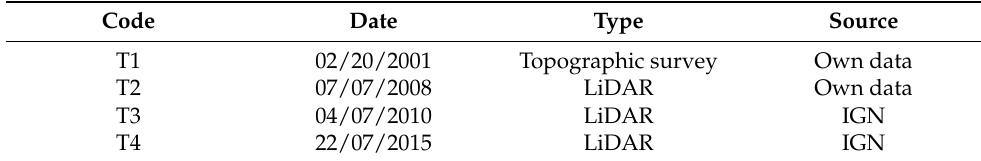
Table 2. Date and type of surface elevation